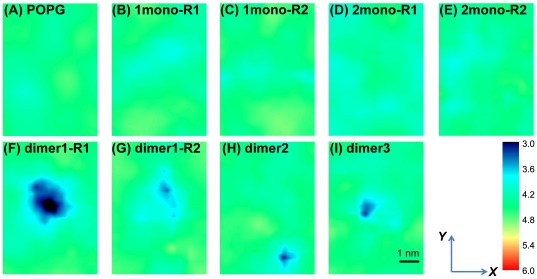
Bilayer thickness distribution map over the x-y lateral plane in each MD run.The x-y lateral plane of each bilayer has a size of 5 nm×7 nm. The centroid of the peptide system in panels (B)∼(I) is in the center of simulation box. The black color in panel (F) indicates that the local thickness of the POPG bilayer is less than 3 nm.